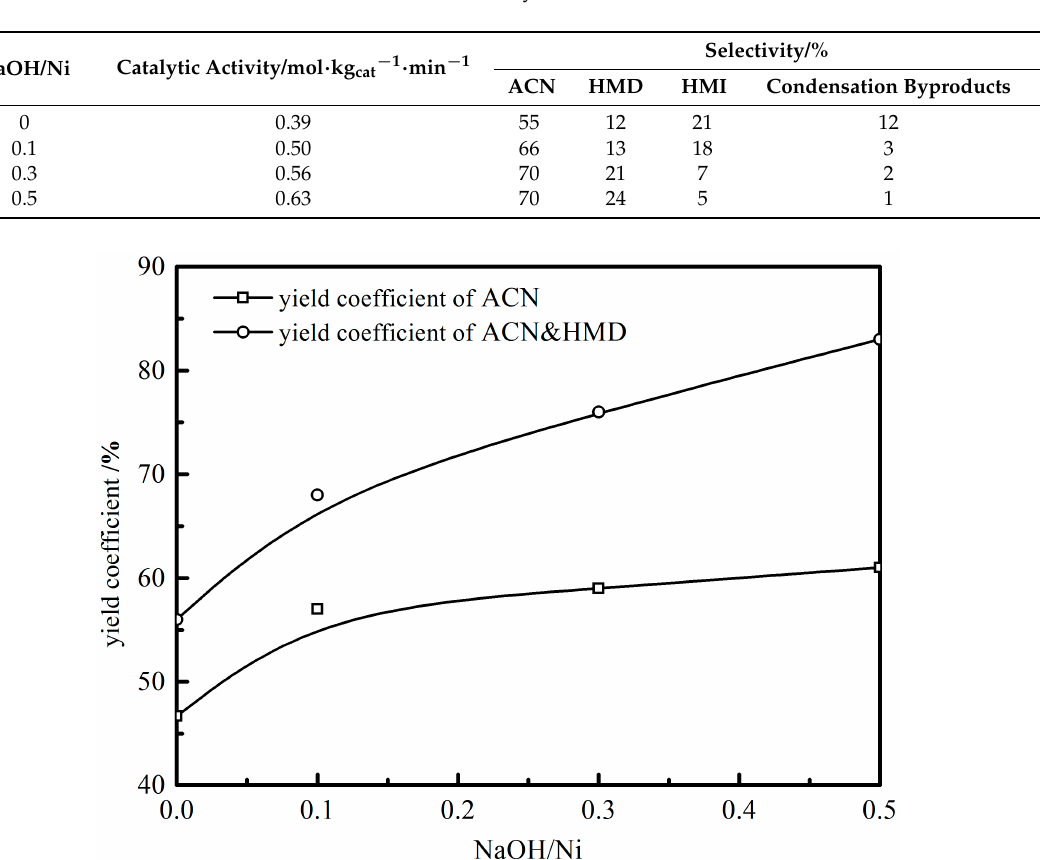
Table 5. Evaluation reaction result of the catalysts with different NaOH/Ni mass ratio.